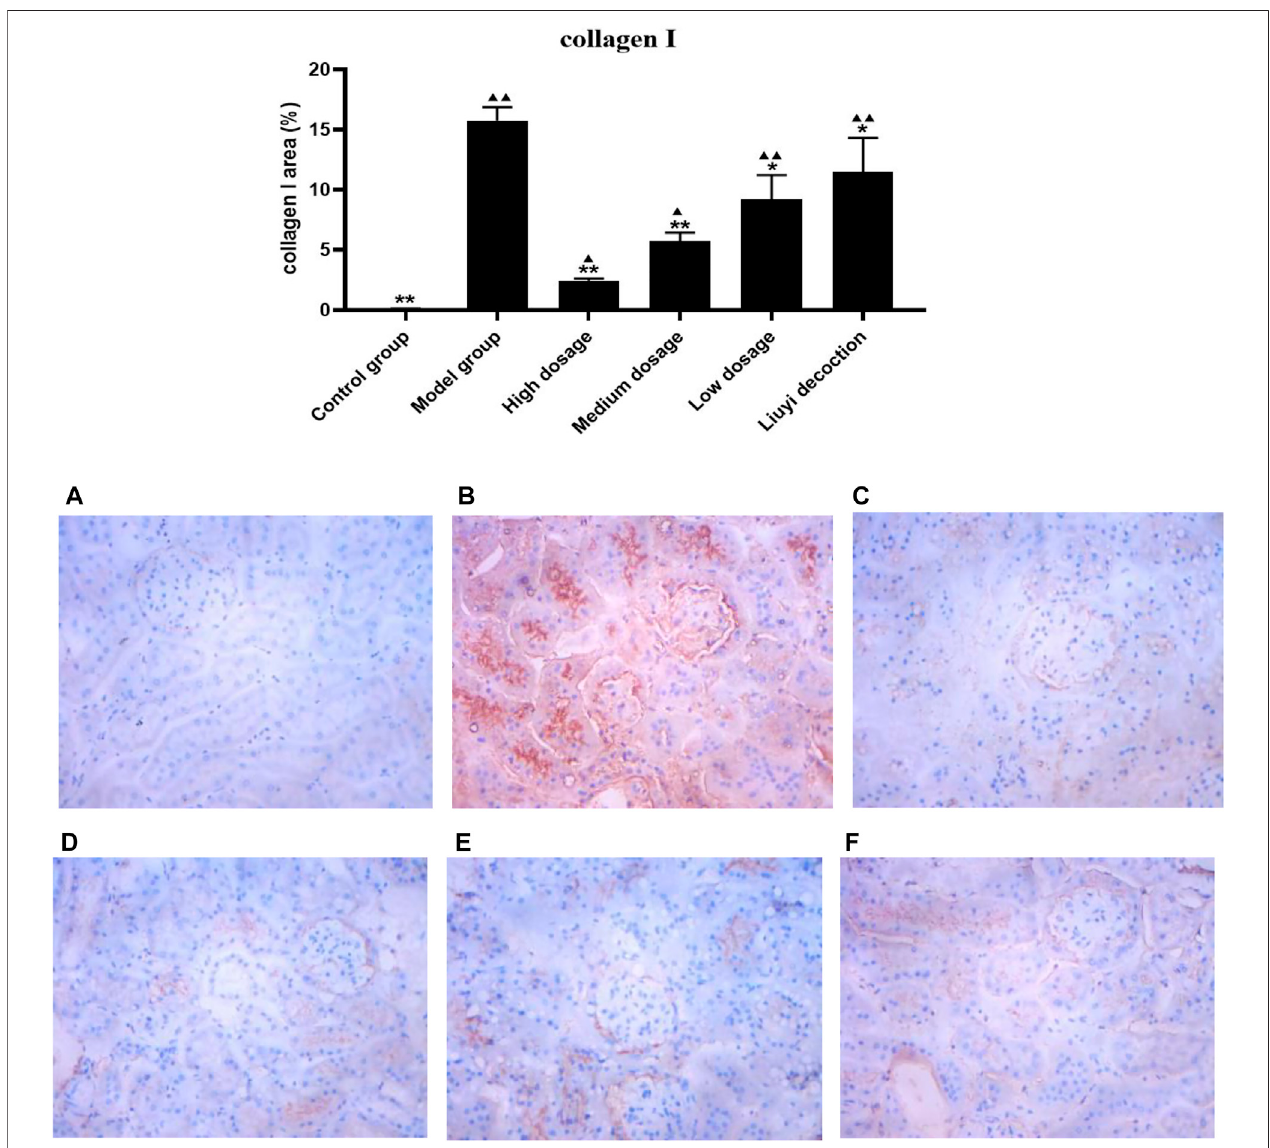
FIGURE5| Effect ofHQDontheexpressions ofcollagenIinkidney(×400).Controlgroup (A) ;modelgroup (B) ;highdosage (C) ;medium dosage (D) ;lowdosage (E) ; Huangqi Liuyi decoction (F) . ps: vs. Model group, * P < 0.05, ** P < 0.01; vs. control group, ▲ P < 0.05, ▲▲ P < 0.01 (x±SD, n =6).